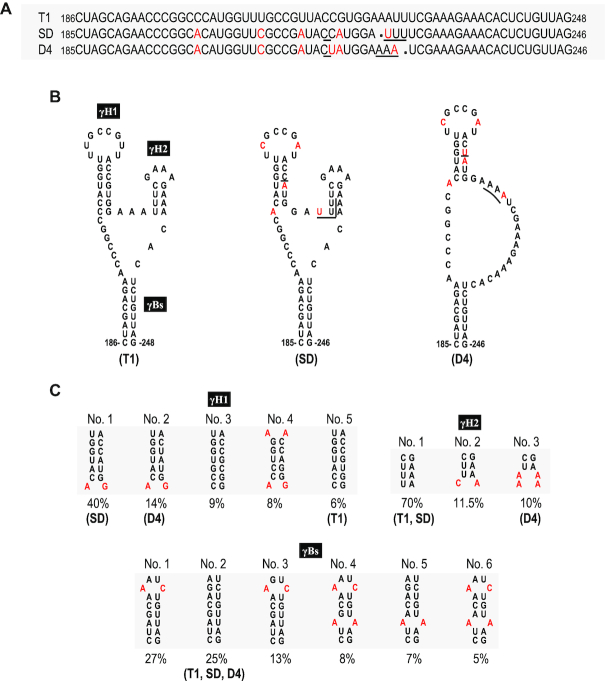
Comparison of the primary sequences and predicted secondary structures of CMV satRNAs. (A) Alignment of the nucleotide sequences of sat-T1, SD and D4 ranging from nucleotide positions 185–246, or 186–248. The nucleotides of sat-SD or sat-D4 that are different from sat-T1 are colored red. In total, there are four nucleotides varying between sat-SD and sat-D4 underlined. (B) The predicted secondary structures for these primary sequences shown in the panel (A). Sat-T1 and sat-SD can be folded into a three-way branched structure containing two hairpins (γH1 and γH2) branched from the basal stem γBs. Compared with sat-T1 or sat-SD, sat-D4 lacks the γH2 hairpin. The nucleotides colored red or underlined are the same as shown in the panel (A). (C) Conservation analysis of the predicted structures. All 182 sequences of CMV satRNAs deposited in GenBank were analyzed. The sequences of these three stems with a frequency of ≥5% are shown here.